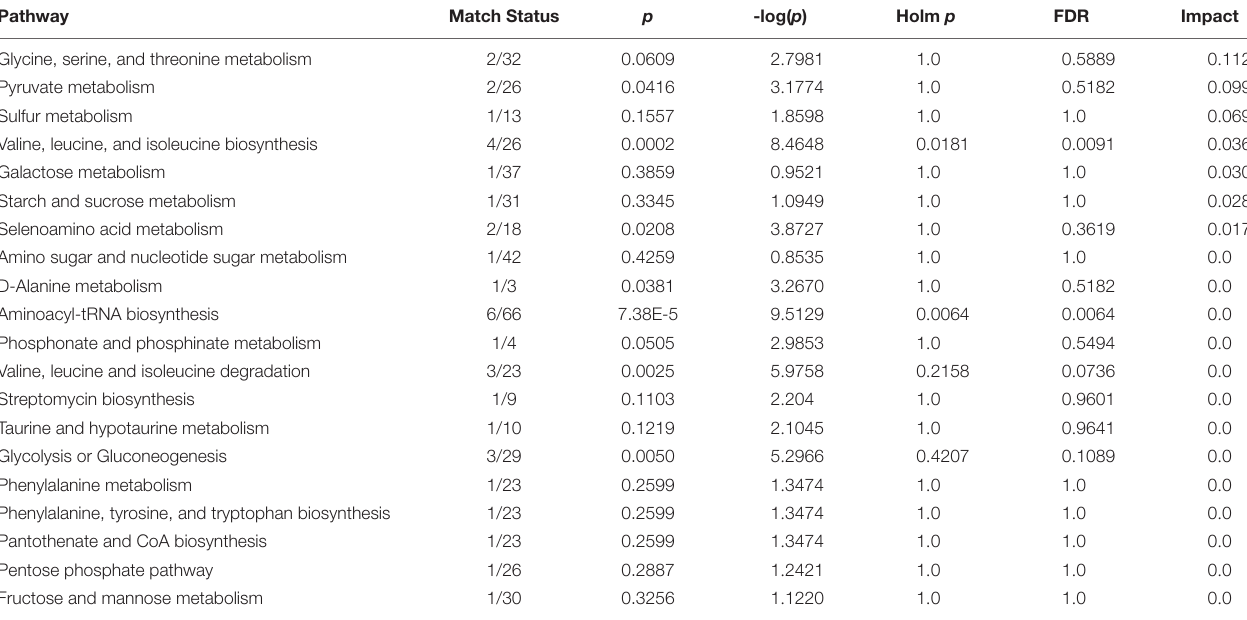
TABLE 5 | Pathway analysis performed using MetaboAnalyst 4.0 about CFS of Lactobacillus strains grown in MRS with glycerol.